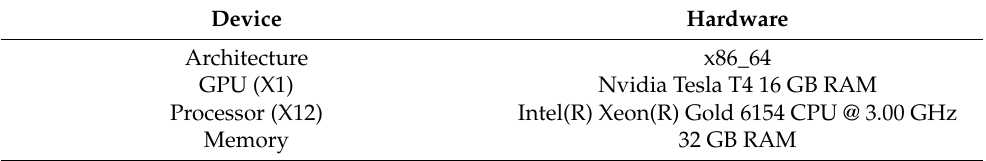
Table 7. Hardware used for the learning